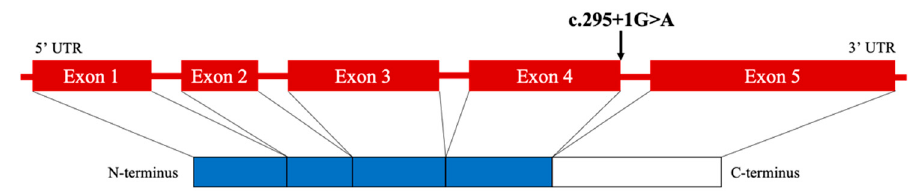
Figure 4. Schematic diagram of MAX mutation in the patient. UTR, untranslated region.